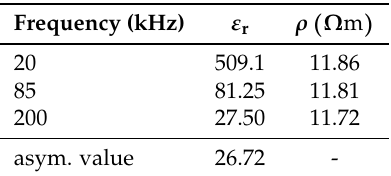
Table 2. Values of relative permittivity and resistivity at three different frequencies after 28 days from